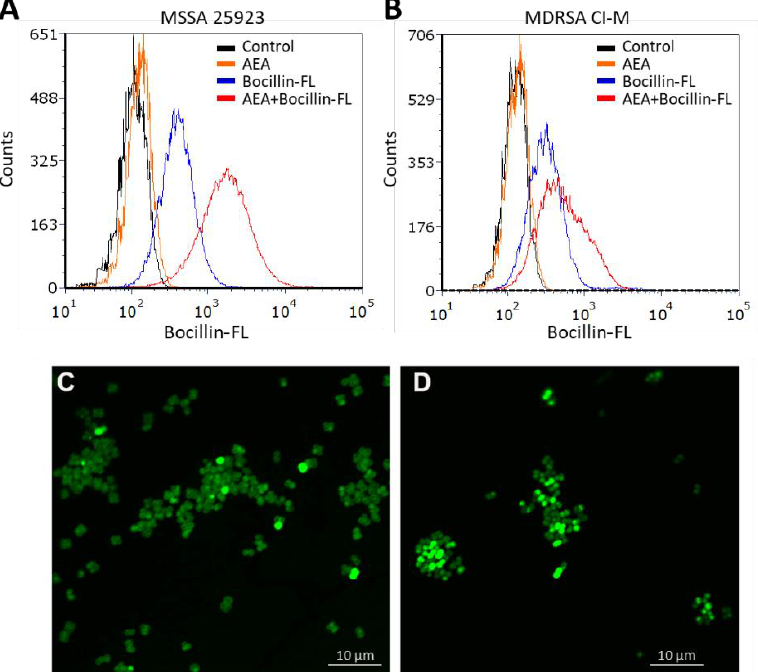
Figure 2. AEA increases the intracellular level of the penicillin analog Bocillin-FL both in methicillin-sensitive (ATCC 25923) and methicillin-resistant S. aureus (MDRSA CI-M). ( A , B ). Flow cytometry of S. aureus ATCC 25923 ( A ) and MDRSA CI-M ( B ) that have been incubated with 10 µg/mL Bocillin-FL in the absence or presence of 50 µg/mL AEA for 1 h in TSBG. The green fluorescence of Bocillin-FL was read using the excitation 488 nm laser and emission 520 nm filter. ( C , D ). Spinning disk confocal microscopy of MDRSA CI-M that has been incubated with 10 µg/mL Bocillin-FL in the absence ( C ) or presence ( D ) of 50 µg/mL AEA for 2 h. The green fluorescence was visualized using the 488 nm excitation laser and the green filter.